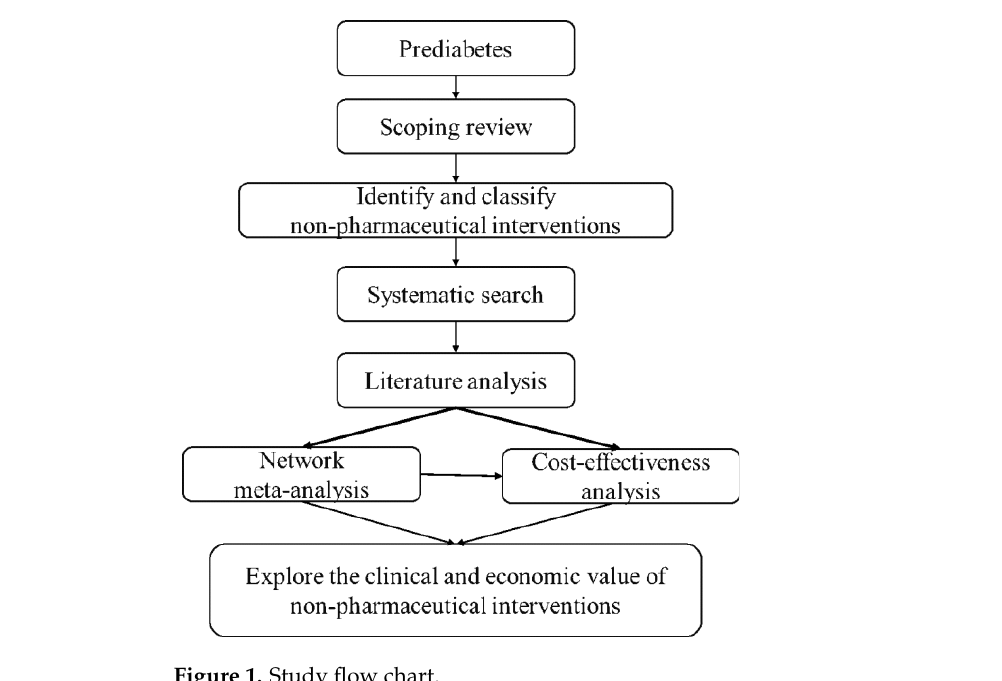
Figure 1. Study flow chart.